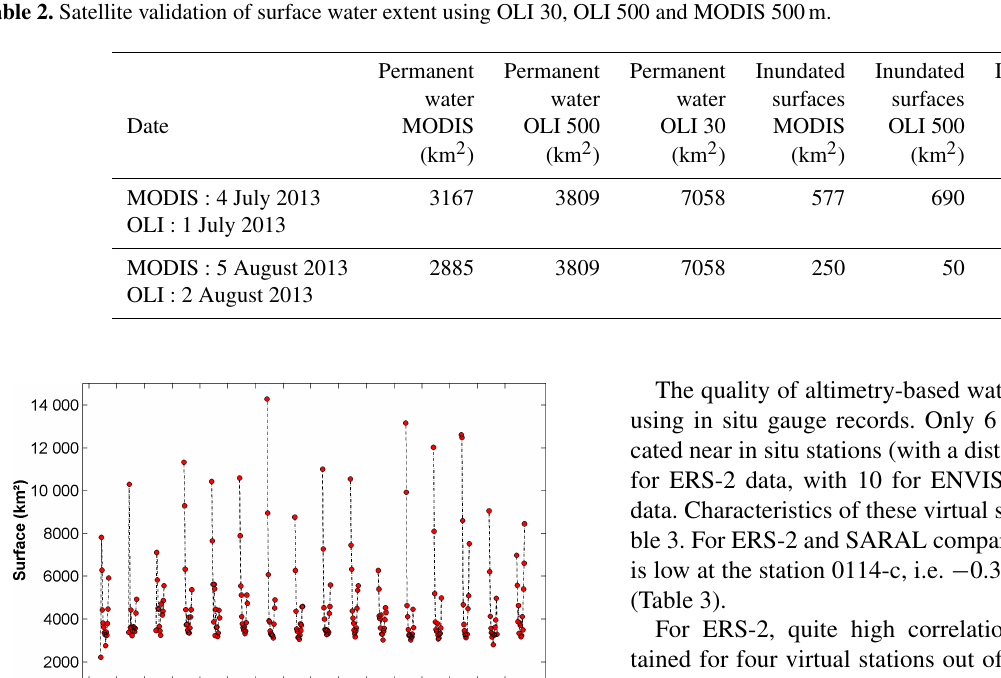
Table 2. Satellite validation of surface water extent using OLI 30, OLI 500 and MODIS 500m.